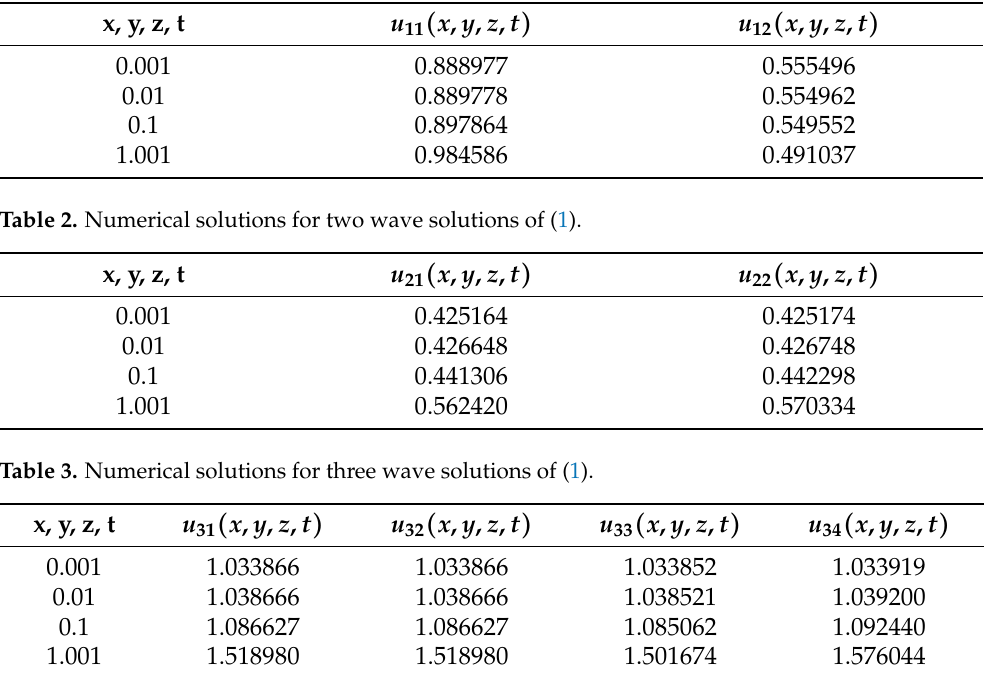
Table 1. Numerical solutions for one wave solutions of (1).